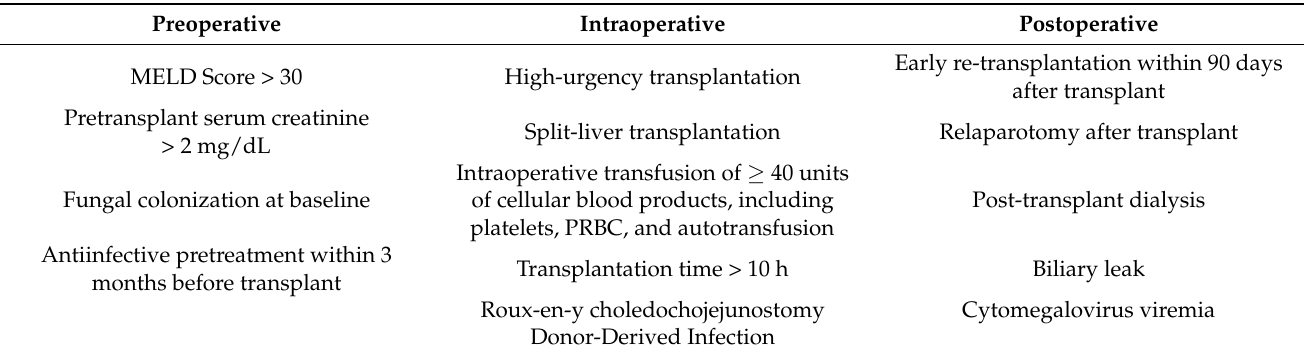
Table 1. Perioperative risk factors for invasive fungal